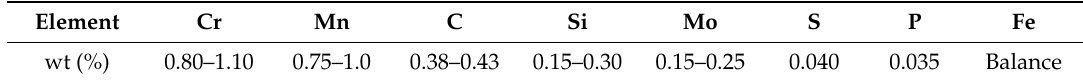
Table 2. 4140 steel chemical